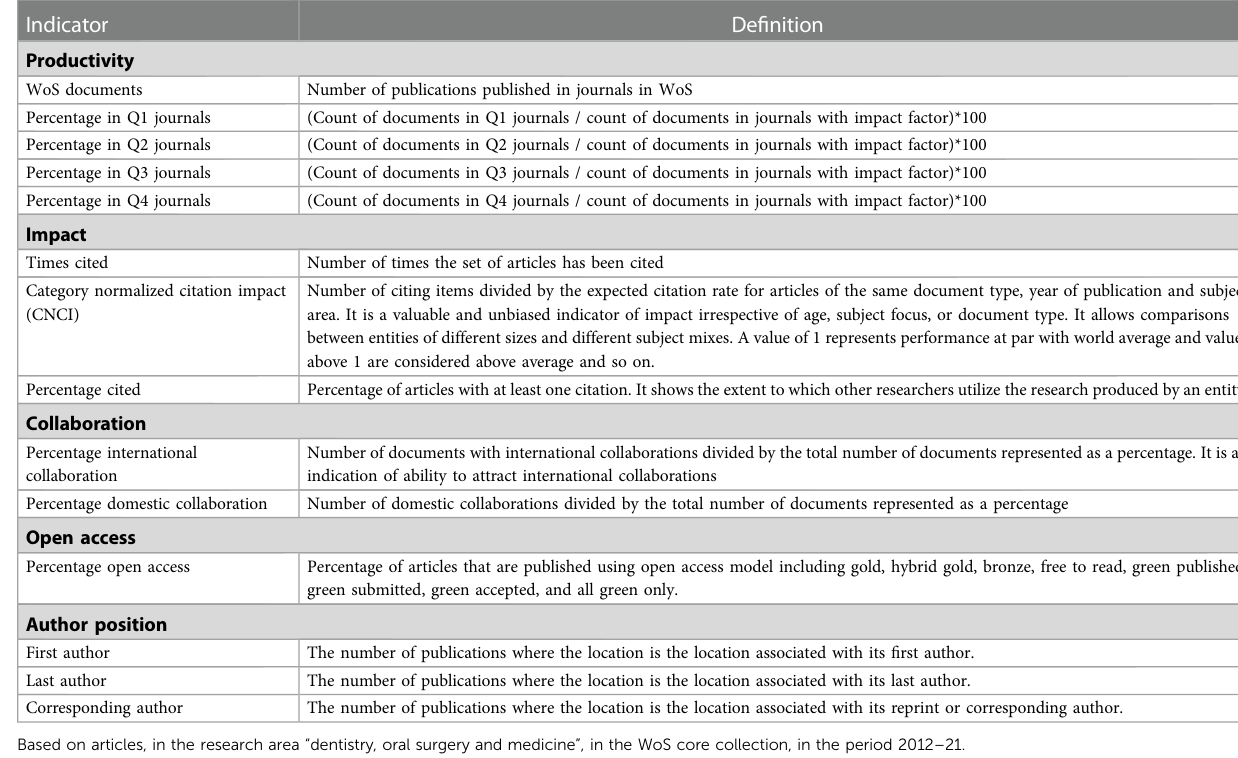
TABLE 1 De fi nition of research indicators used in the